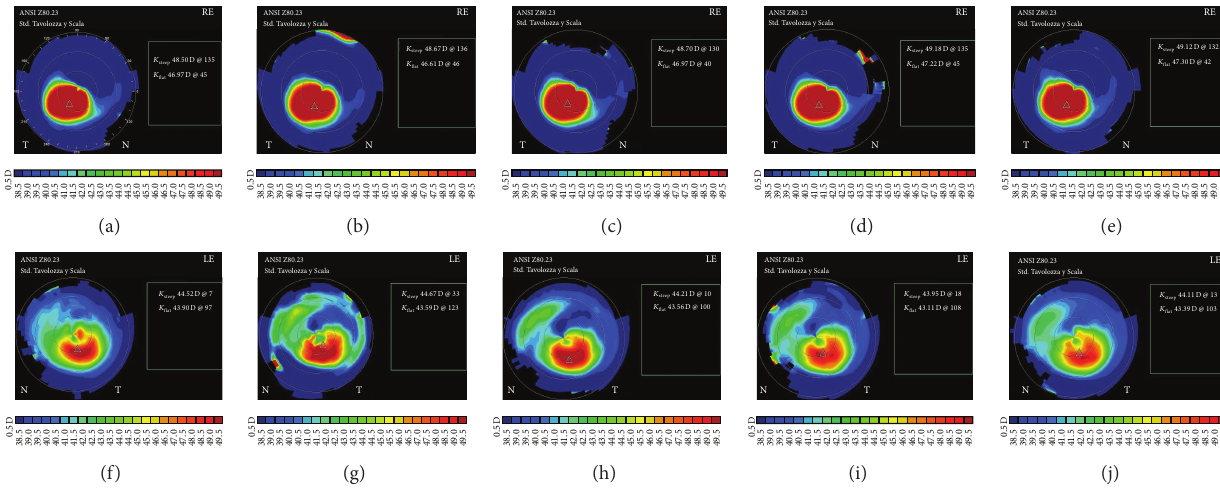
Figure 4: Tangential corneal topography maps in a patient who underwent transepithelial corneal cross-linking in the right eye (A1500) and standard cross-linking in the left eye (B700). The preoperative, 1-week, and 1-, 3-, and 6-month postoperative maps are shown from the left to right, respectively. At 6 months, the flattening of 𝐾 max was 1.74 D (from 59.46 D to 57.72 D) and 0.92 D (from 50.55 D to 49.63 D) in the right and left eye, respectively. Scale bars are normalized and shown in diopters. RE: right eye; LE: left eye; 𝐾 steep and 𝐾 flat represent the simulated keratometry